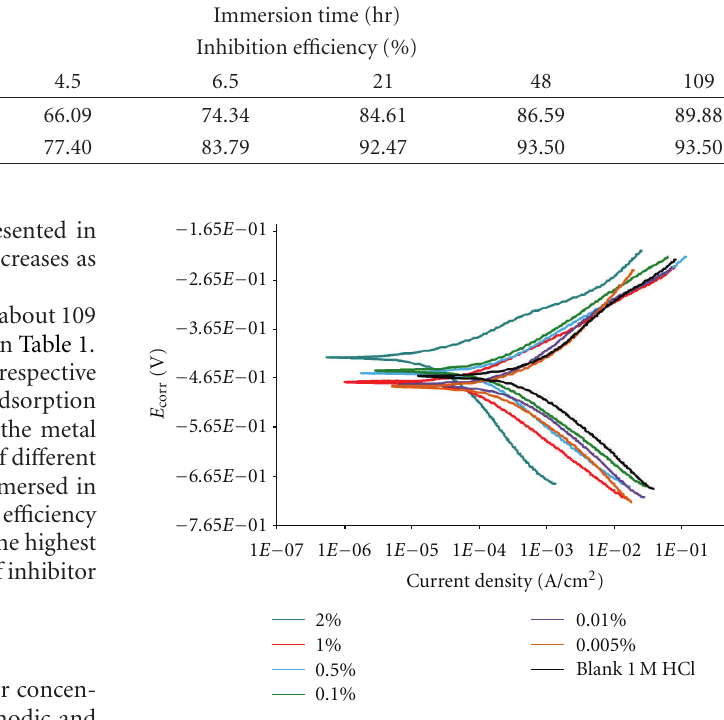
Figure 1: Anodic and cathodic plots of carbon steel 1018 in 1M HCl solution in the absence and presence of various concentrations of Pachycormus discolor ethanol extract.